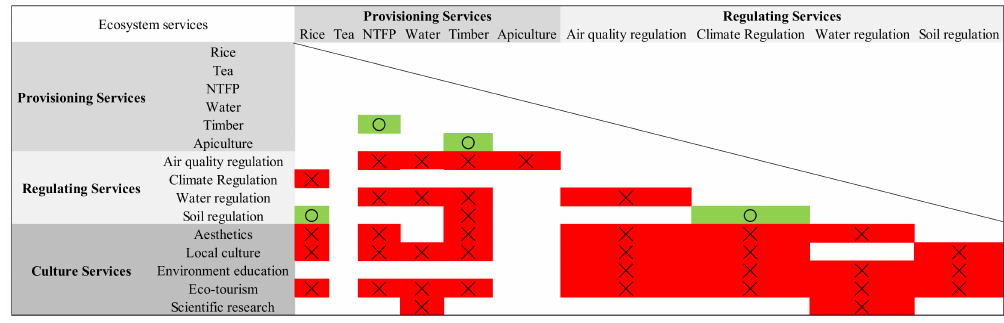
Figure 4. Significant trade-off and synergy of the perceived importance of ecosystem services.